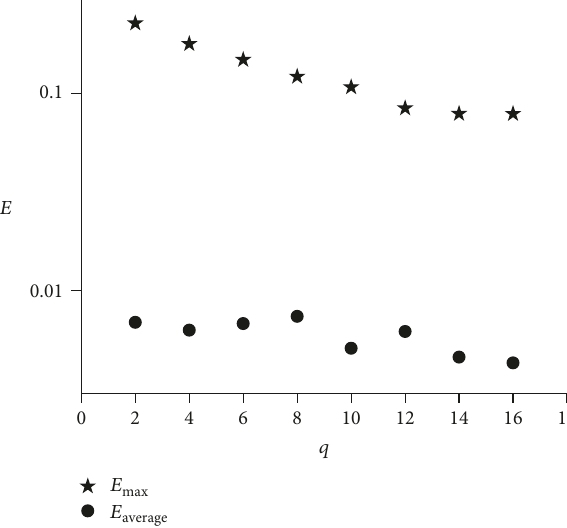
Figure 5: Bottom: average repulsive energy per wire in the bar code as function of the number of bars 𝑞 (or narrowness of the bars); top: maximum repulsive energy for any wire in the configuration with 𝑞 bars (located at the star position in previous figure).